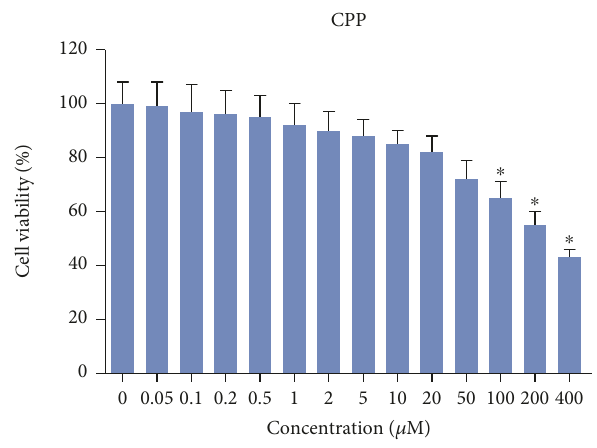
Figure 1: Cell viability of HepG2